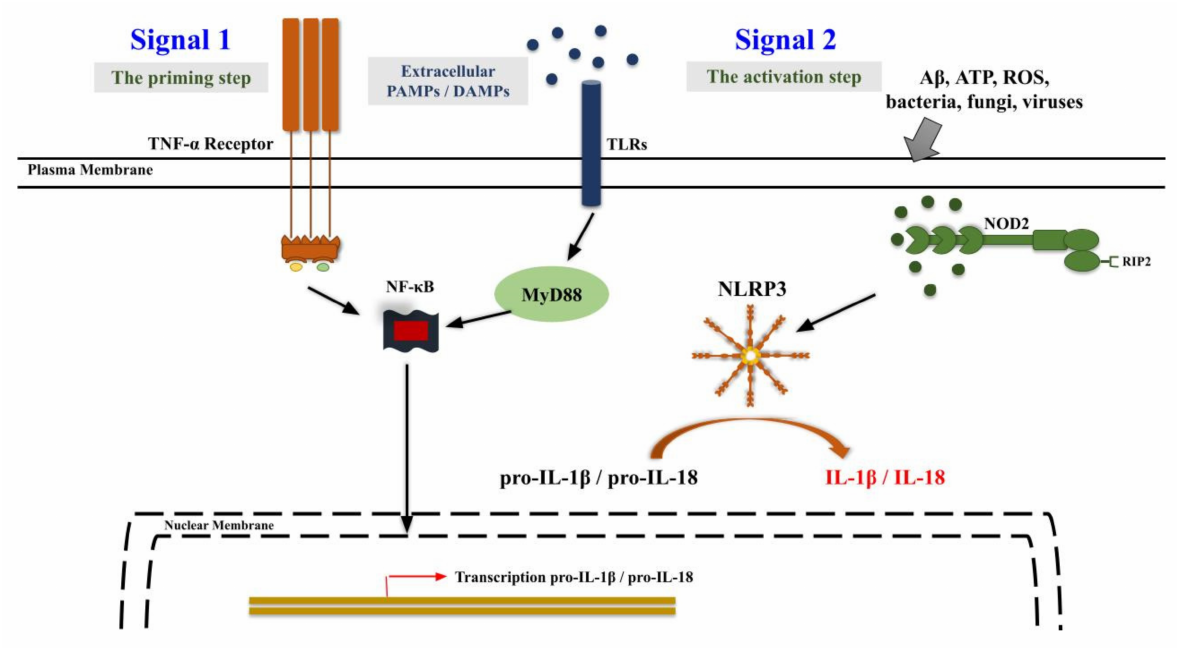
Figure 3. The ways through which the NLRP3 inflammasome is activated: The activation of the NLRP3 inflammasome is a complicated regulatory mechanism that requires two triggering steps: priming and activation. TLR4 or TNF- α receptor agonists cause the priming phase (signal 1), which then activates the NF-B pathway by boosting the production of pro-IL-18 and pro-IL-1. The NLRP3 inflammasome is then stimulated (activation step) by numerous triggering events, such as A β , ATP, ROS, bacteria, fungi and viruses (signal 2). Then, caspase-1 can induce maturation of IL-18 and IL-1.